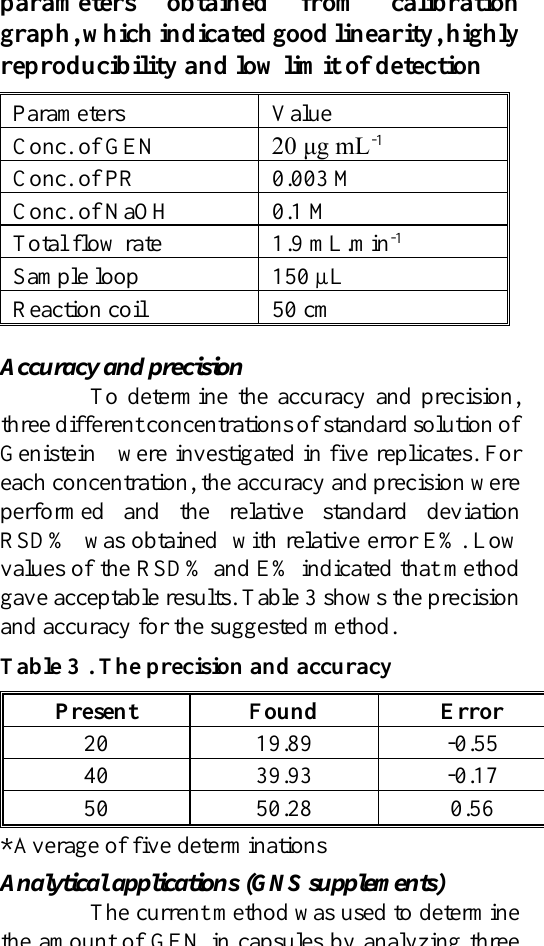
Table 1. Summary of